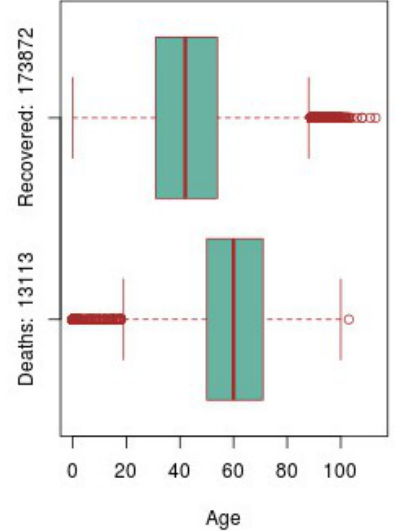
Figure 9. Double Age boxplot comparison of recovered cases against deaths.